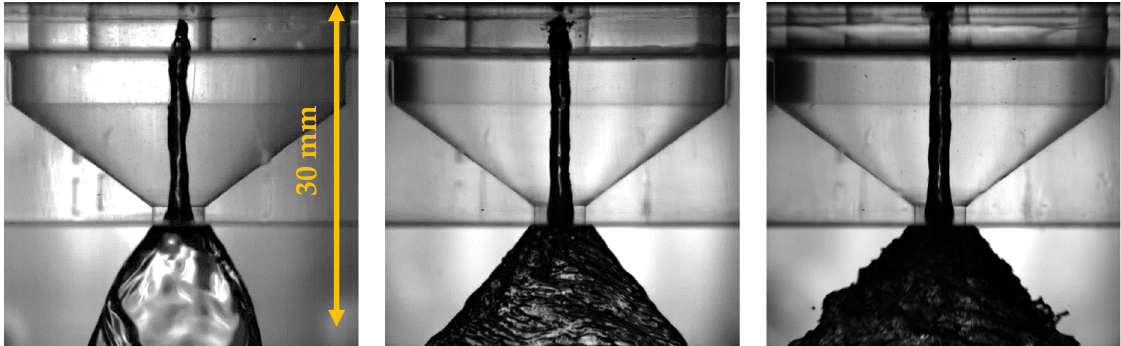
Figure 4. Typical results obtained from HS imaging. From left: Re = 1000, 2000 and 4000. The measured swirl velocity profiles are identical in all axial positions, see Figure 5.